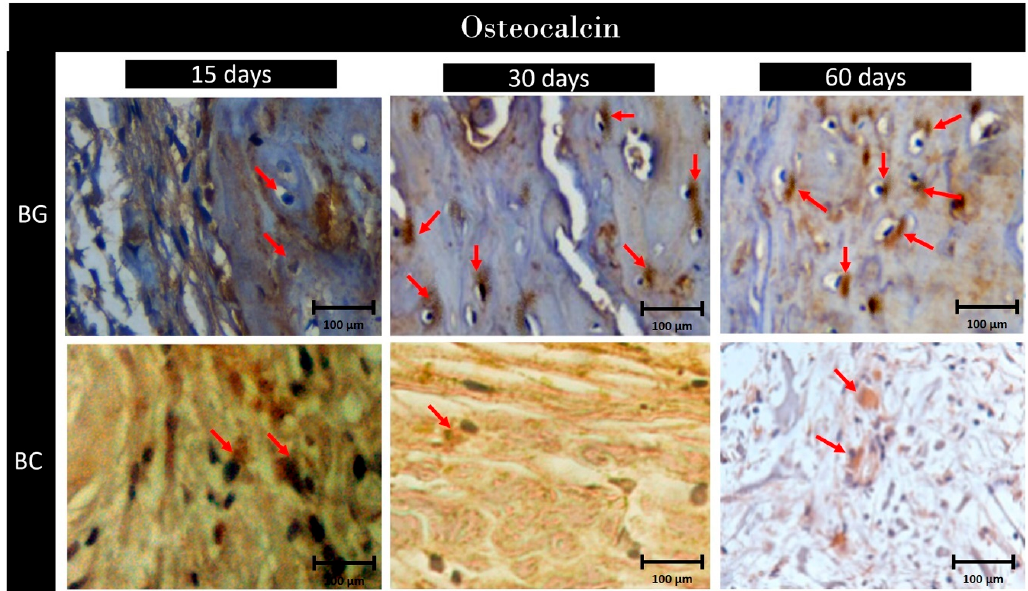
Figure 8. Photomicrographs of the immunohistochemical analyses in 15, 30, and 60 days highlight osteocalcin reaction at ×40.0 magnification. The red arrows indicate labeling. 1, 2, and 3 indicate mild, moderate, and intense labeling, respectively. Membranes 2020 , 10 , x FOR PEER REVIEW